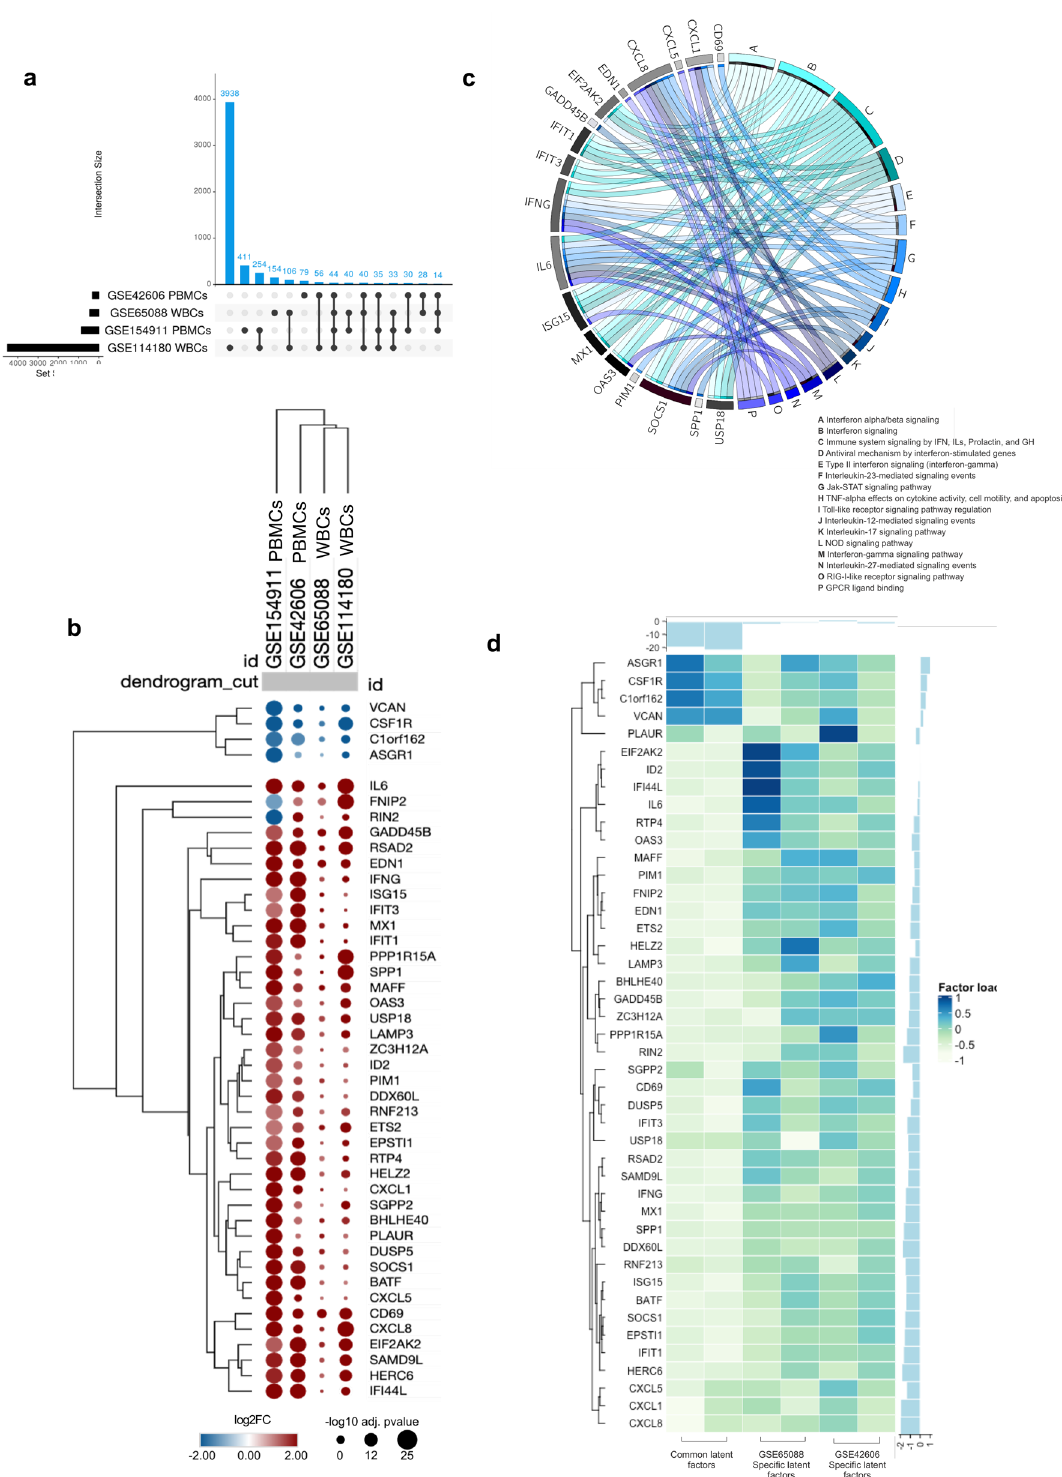
Figure 2. C. albicans activates common TLR- and IFN-associated genes in peripheral blood leukocytes. ( a ) The upper plot displays the number (set size) of DEGs present in each dataset (y-axis: WBCs, GSE65088, and GSE114180; PBMCs: GSE42606 and GSE154911) and their intersections. Black bubbles, present in rows, mark the dataset, which refers to the amount present in the blue columns, with intersections between two or more groups being shown. ( b ), Hierarchical clustering of the 44 common DEGs demonstrating gene expression patterns across different studies. The size and color of circles correspond to − Log10 transformed adjusted p value and Log2- fold change (Log2FC), respectively. Blue represents downregulated DEGs, and red indicates upregulated DEGs. The cutoff applied to identify the down/upregulated genes was Log2FC < − 1/ > 1 and adjusted p value < 0.05. Rows and columns were clustered based on cosine similarity between Log2FC values. ( c ), GOplot of selected immunological pathways and associated genes. ( d ), Heatmap of common and specific latent factors across studies. Heatmaps contain genes presenting positive and negative loadings ranging from − 1 to 1. DEGs , differentially expressed genes; PBMCs, peripheral blood mononuclear cells; WBCs, white blood